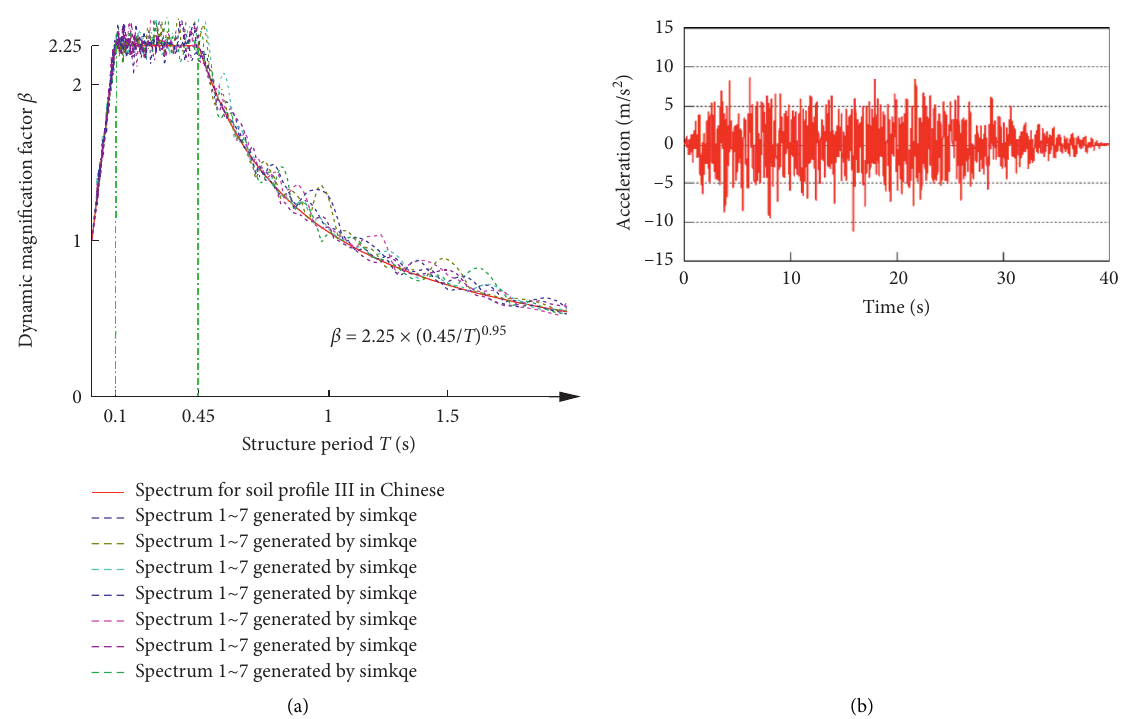
Figure 2: Earthquake input: (a) response spectra for soil profile III in Chinese criteria (JTJ 004-89) and generated by Simqke and (b) one accelerogram corresponding to